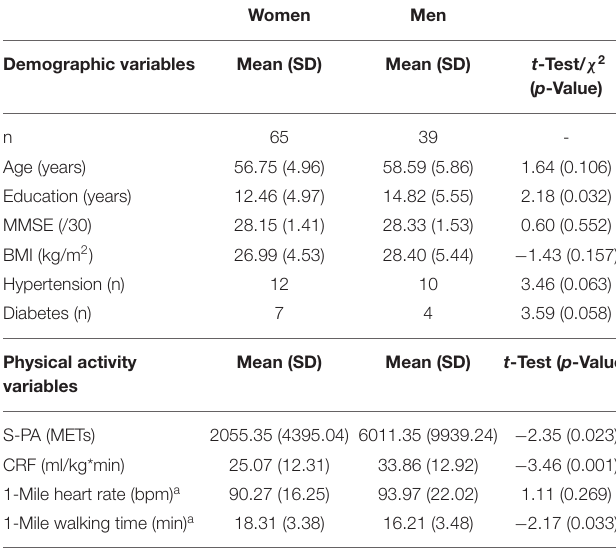
TABLE 1 | Demographic and physical activity